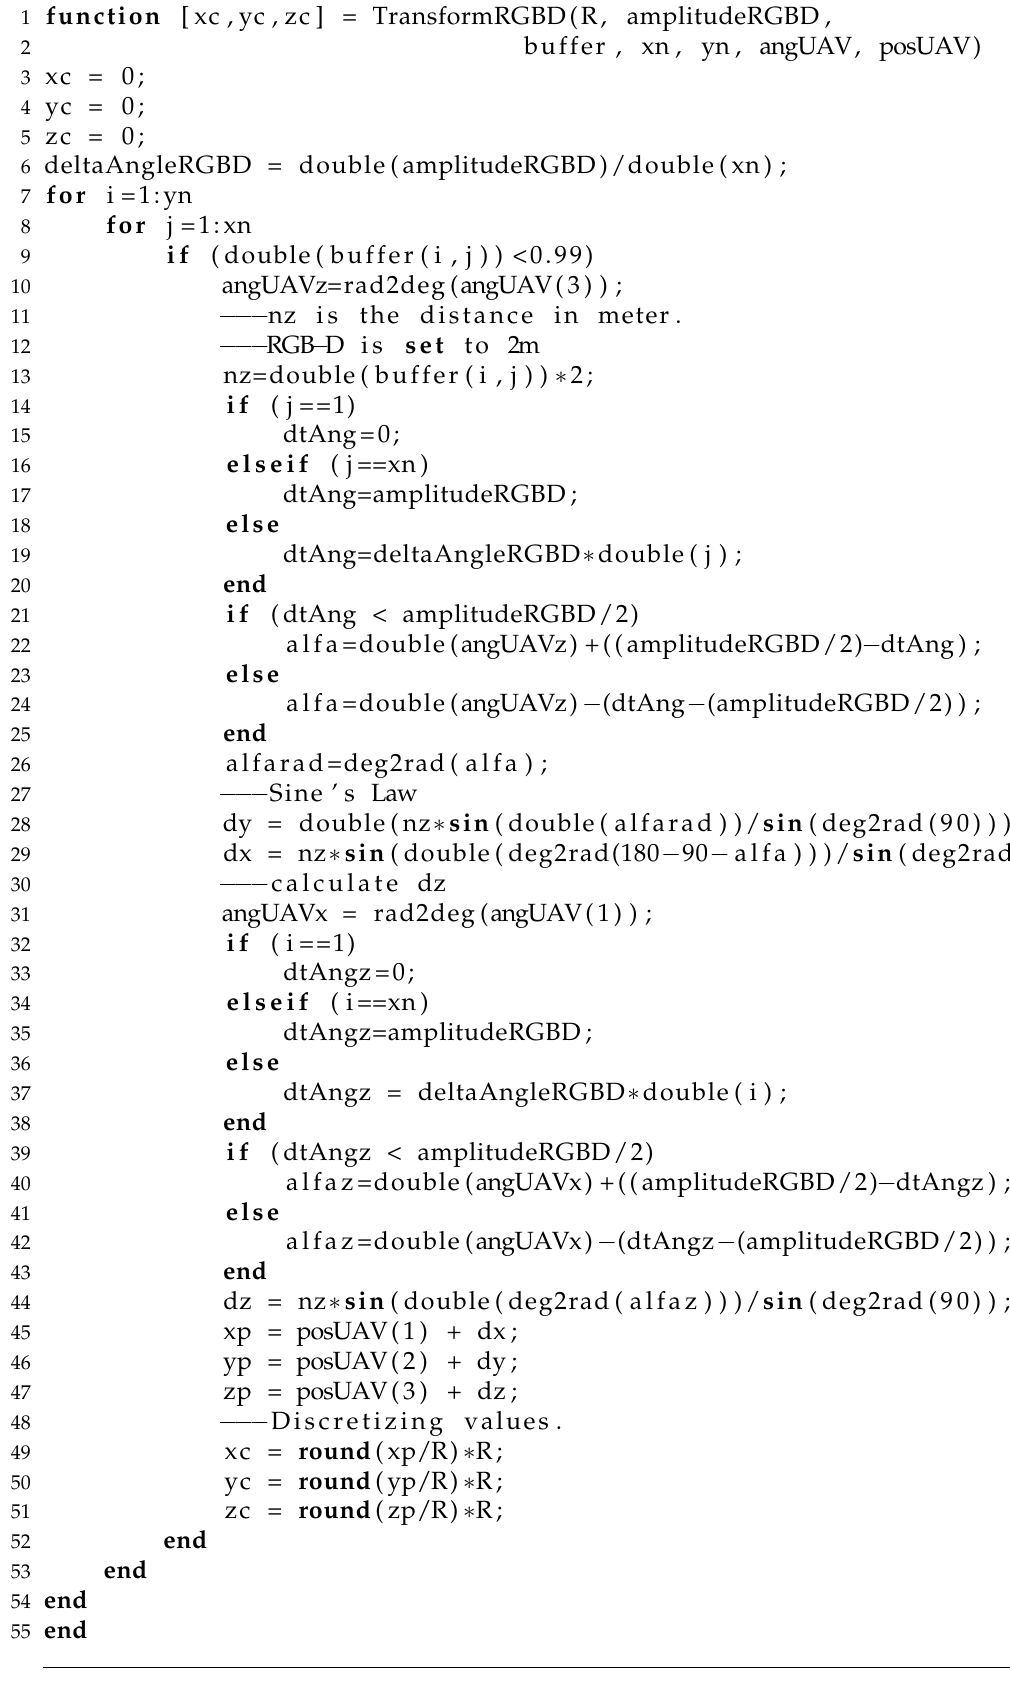
Algorithm 1 RGB-D transformation